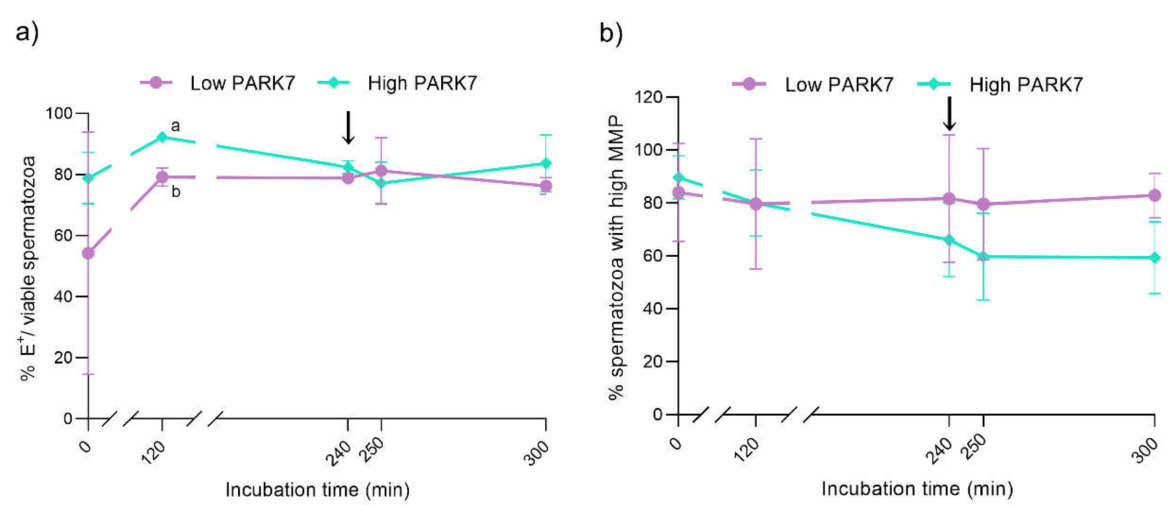
Figure 6. Percentages of sperm with high intracellular O 2 − levels in relation to viable sperm (E + /viable sperm) ( a ) and sperm exhibiting high mitochondrial membrane potential (MMP) ( b ) during in vitro capacitation and acrosomal exocytosis induced by progesterone (300 min). The black arrows indicate the addition of progesterone at a final concentration of 10 µ g/mL (240 min). Data are represented as means ± SD. Different letters indicate significant differences ( p < 0.05) between sperm samples containing high and low relative levels of